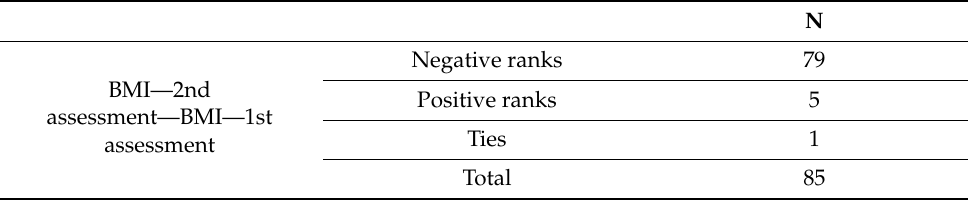
Table 6. Ranks of BMI assessment.